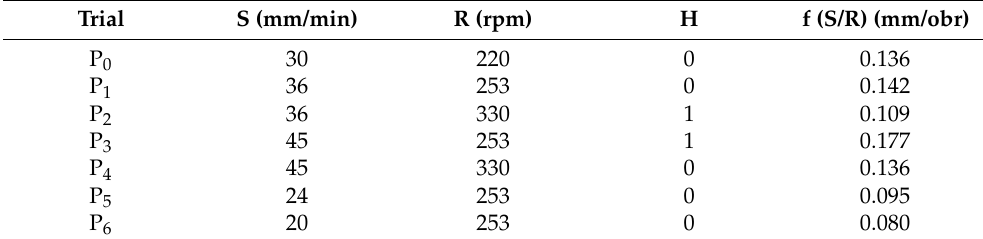
Table 4. The trail